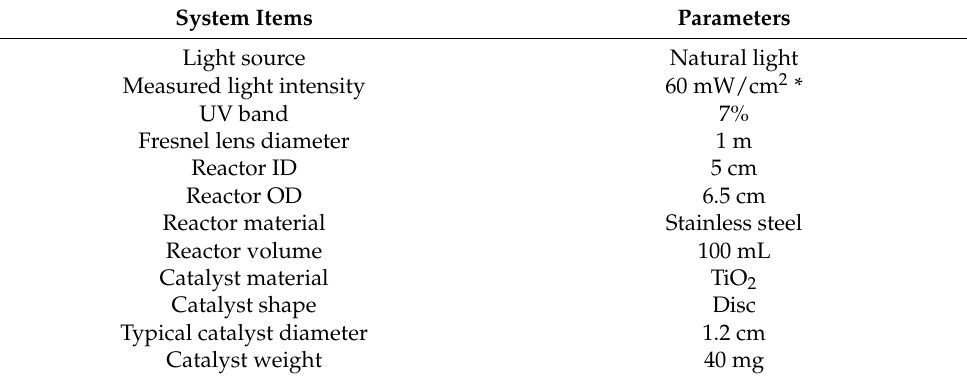
Table 1. Operating parameters of the concentrating solar light reactor